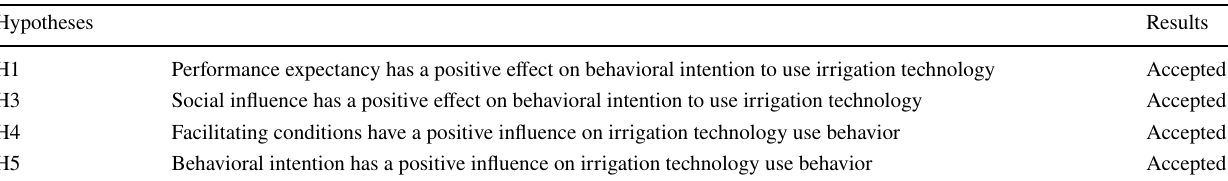
Table 7 Summary of accepted hypotheses